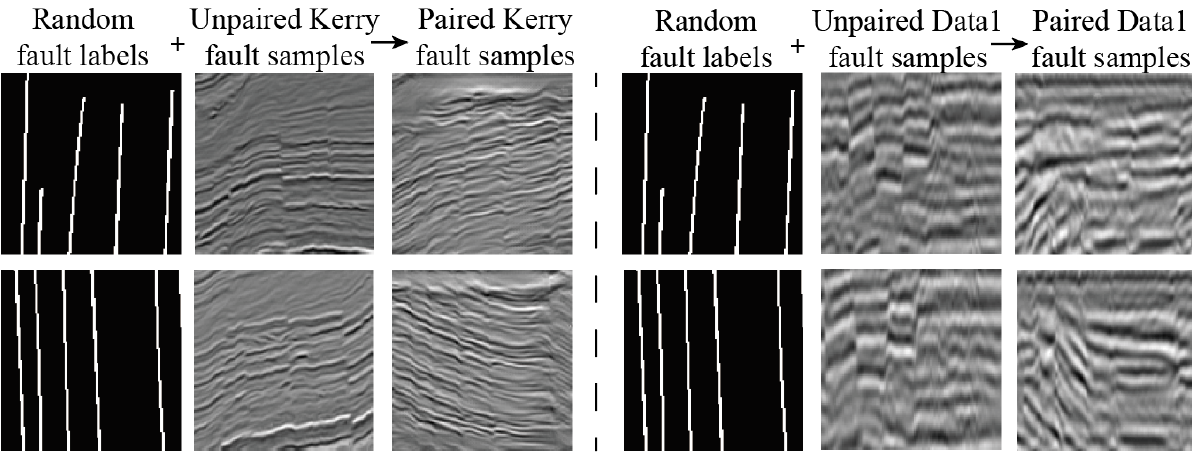
Figure 1. Prepared training samples (column 1 and column 2 are input labels and Kerry faults, and column 4 and column 5 are input labels and Data1 faults, respectively) and expected output (column 3 and column 6).